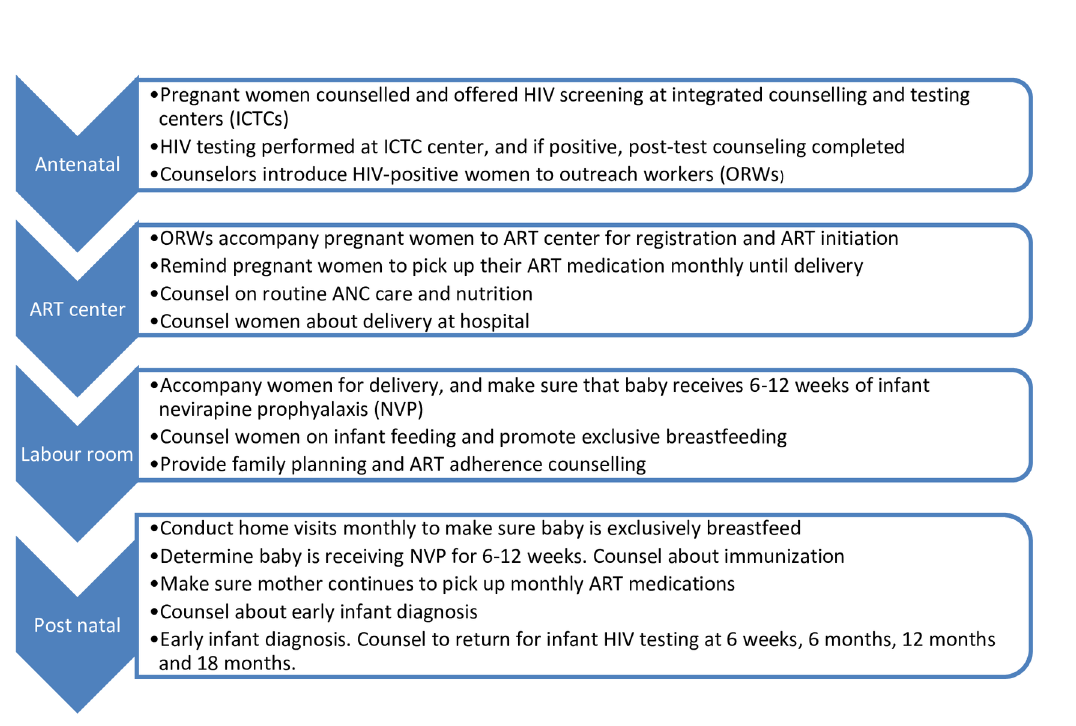
Fig 2. Main components of the PMTCT program, and the role of the outreach